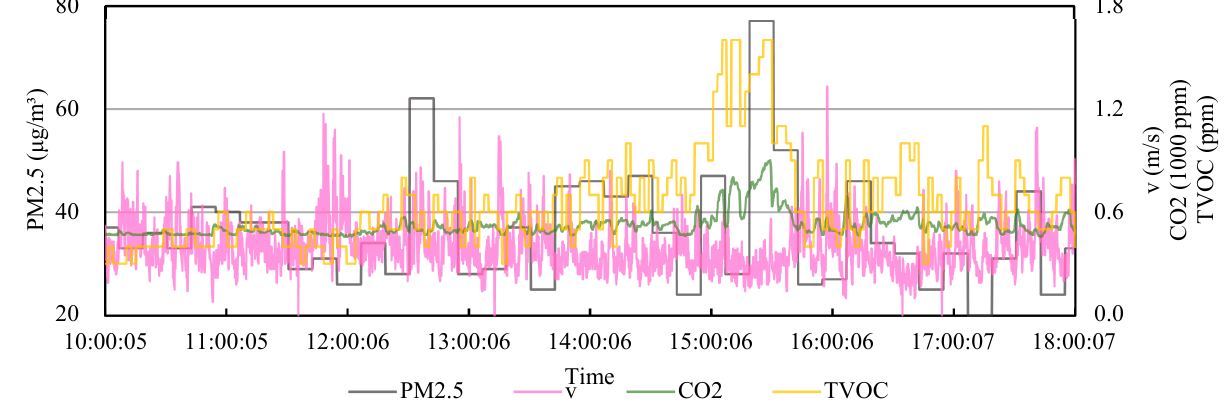
Figure 5. Temporal trend of weakly correlated thermal comfort parameters.